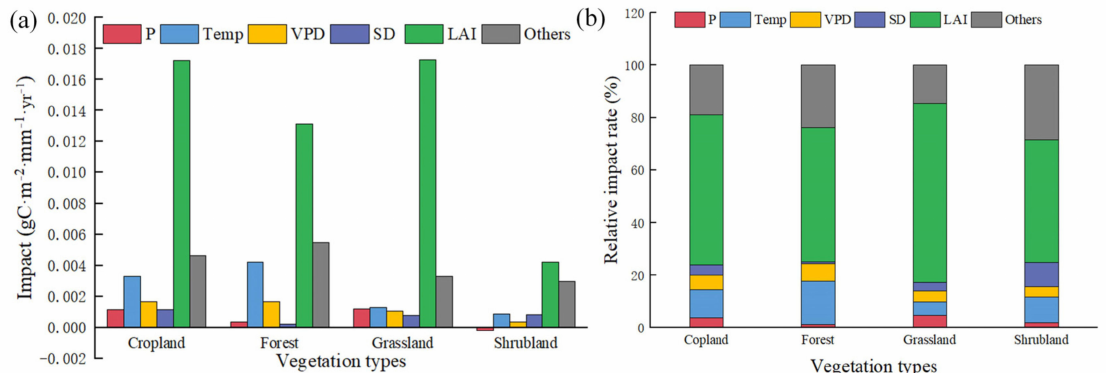
Figure 9. ( a ) Impact rates of the different influencing factors on the WUE trends for different vegetation types, ( b ) relative impact rates of the different influencing factors on the WUE trends for different vegetation